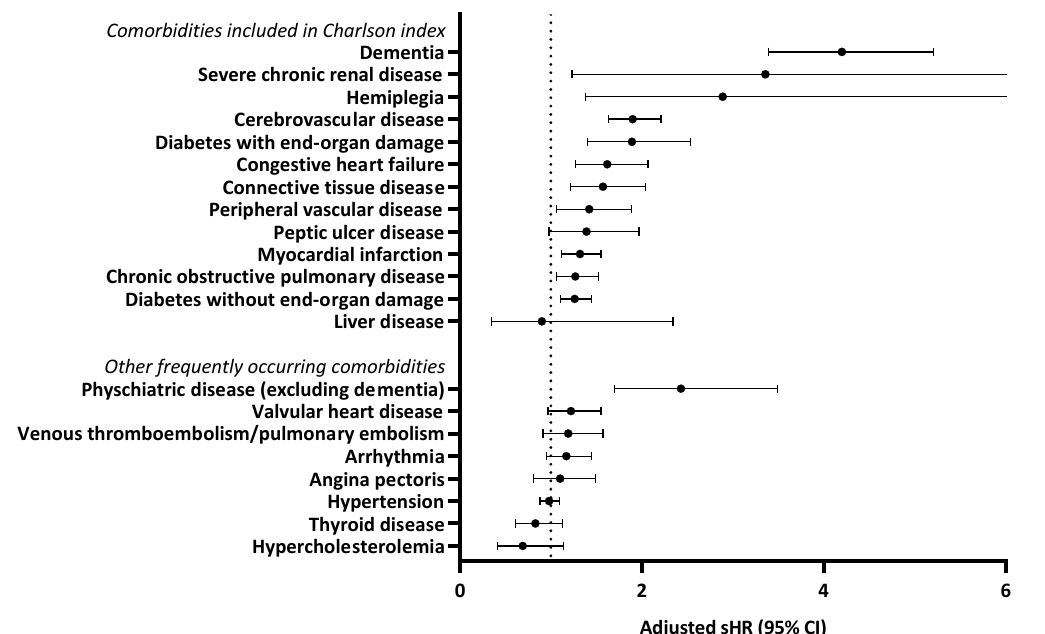
Figure 2. Adjusted subdistribution hazard ratios (sHRs) for 5-year other cause mortality by specific comorbidities. The multivariable model included all other specific comorbidities and age.